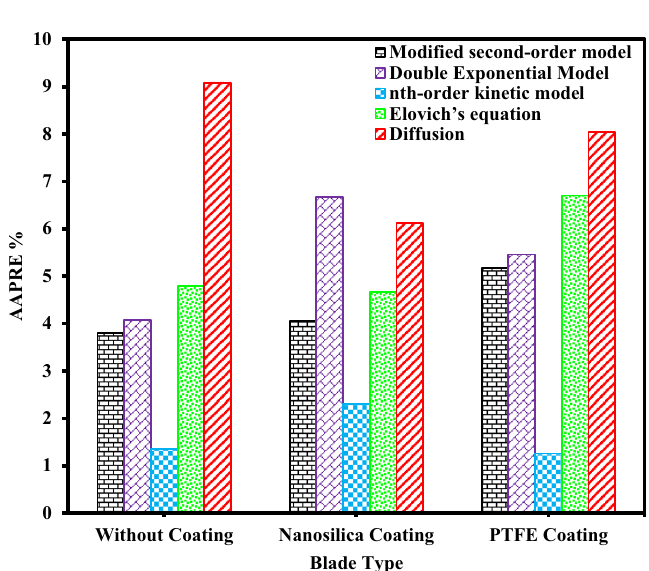
Figure 11. Comparison of deposition kinetics models for different coatings at concentration of 2000 ppm in static state based on